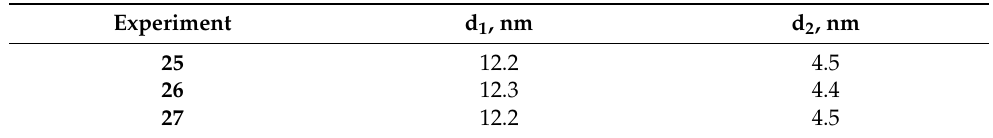
Table 5. Values of PXRD parameters for polymer samples 25 – 27 .